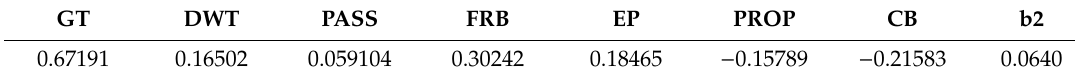
Table 4. The weights and bias of the second layer (output